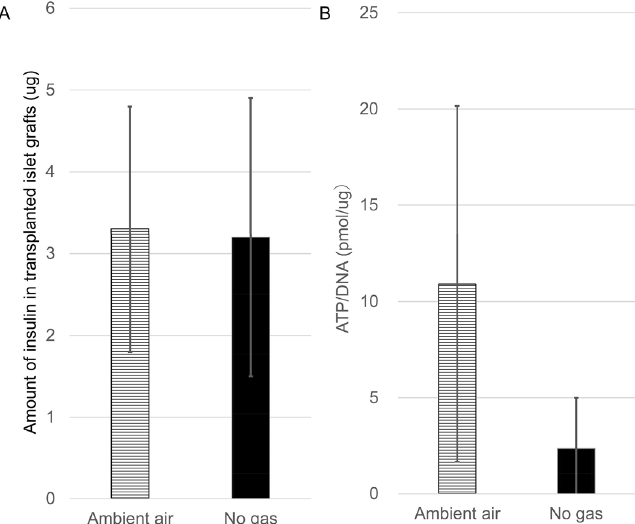
Figure 7. Difference of islet graft viability between the Ambient and No gas groups. ( A ) The amount of insulin in the transplanted islet grafts. Three days after transplantation at the SC, the islet grafts were retrieved, and the amount of insulin was evaluated in the Ambient air (horizontal stripe bar; 3.3 ± 1.5 μg, n = 9) and No gas (black bar; 3.2 ± 1.7 μg, n = 9) groups. p = 0.81 (Paired-samples t test). ( B ) The ATP/DNA of the transplanted islet grafts in the Ambient air (horizontal stripe bar; 10.9 ± 9.3 pmol/μg, n = 5) and No gas (black bar; 2.4 ± 2.6 pmol/μg, n = 5) groups. p = 0.07 (Paired-samples t